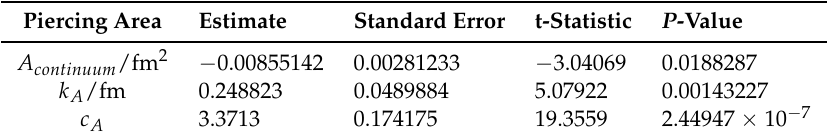
Table 2. The parameters of fitting A lattice ( a ) = A continuum + k A piercing area on the lattice. The dominance of the quadratic factor c A over the linear factor k A and the near to zero value of A continuum indicate a vanishing vortex thickness in the